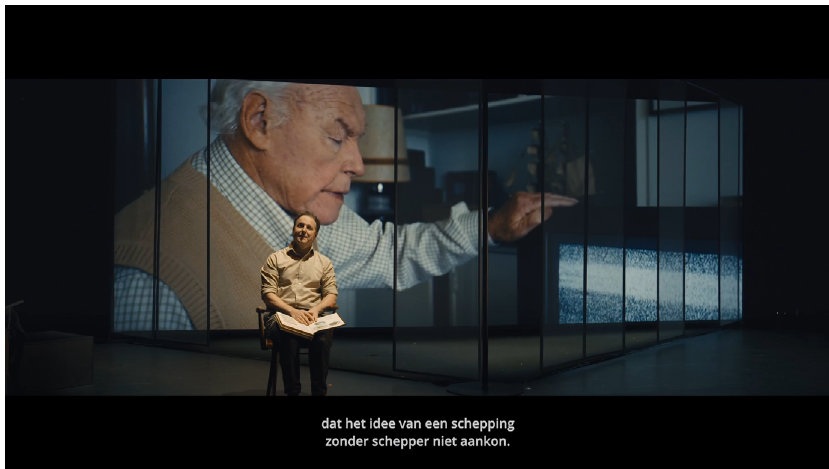
Fig. 3 – Timothy West and Samuel West, as old and young Geiser. Michel van der Aa, The Book of Water , still